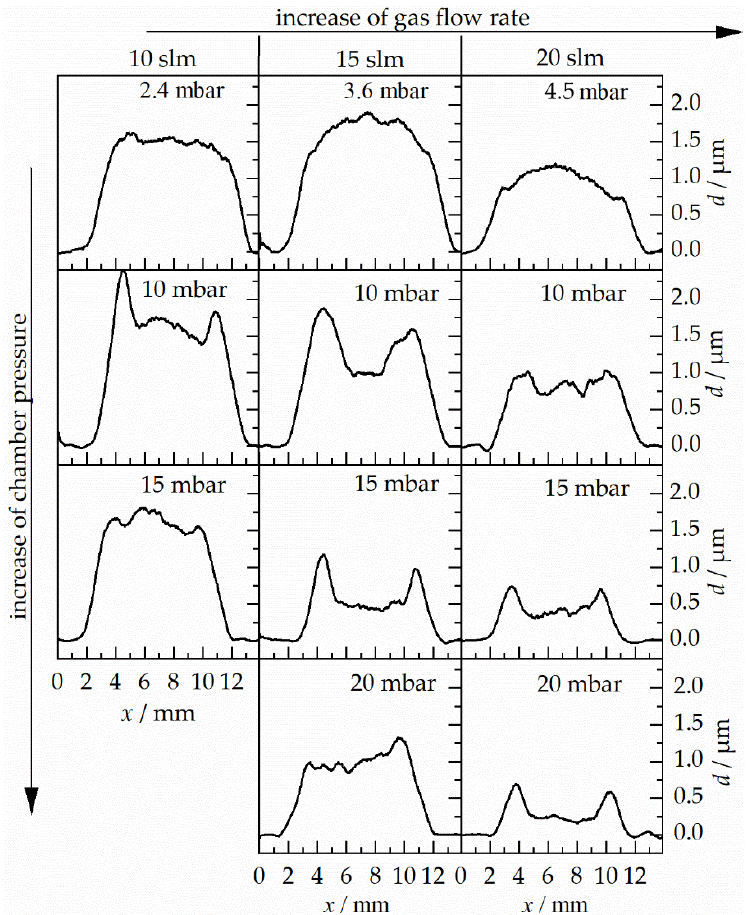
Figure 8. Film thickness profiles (film thickness ( d ) over film width ( x )) of the as-deposited films prepared at different PAD parameter sets (variation of chamber pressure ( p c ) and gas flow rate ( V ̇ )).